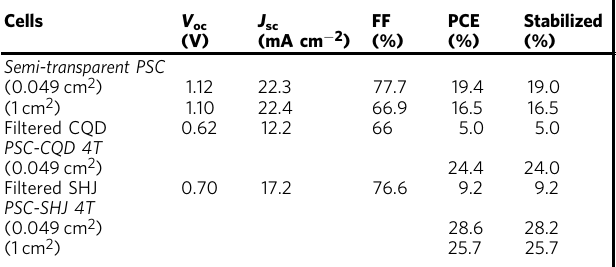
Table 1 Photovoltaic parameters of PSC top cell, CQD, and SHJ bottom